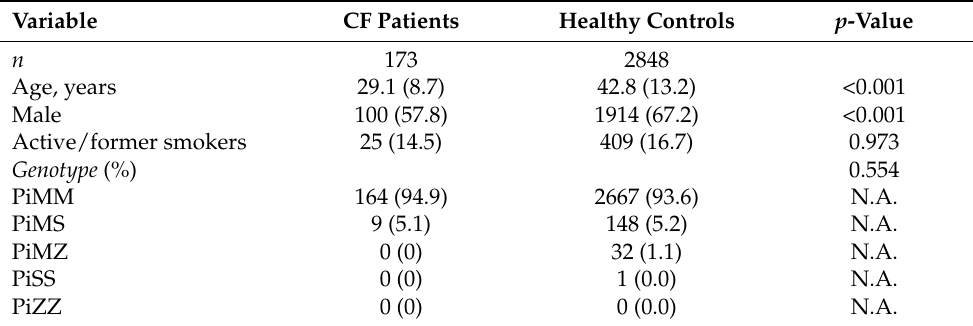
Table 3. Study cohort and prevalence of SERPINA1 variants in